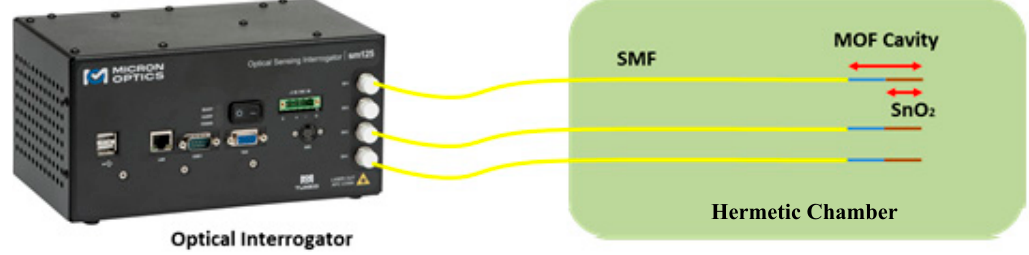
Figure 2. Experimental setup used to analyze the response of the sensors towards saturated atmospheres of